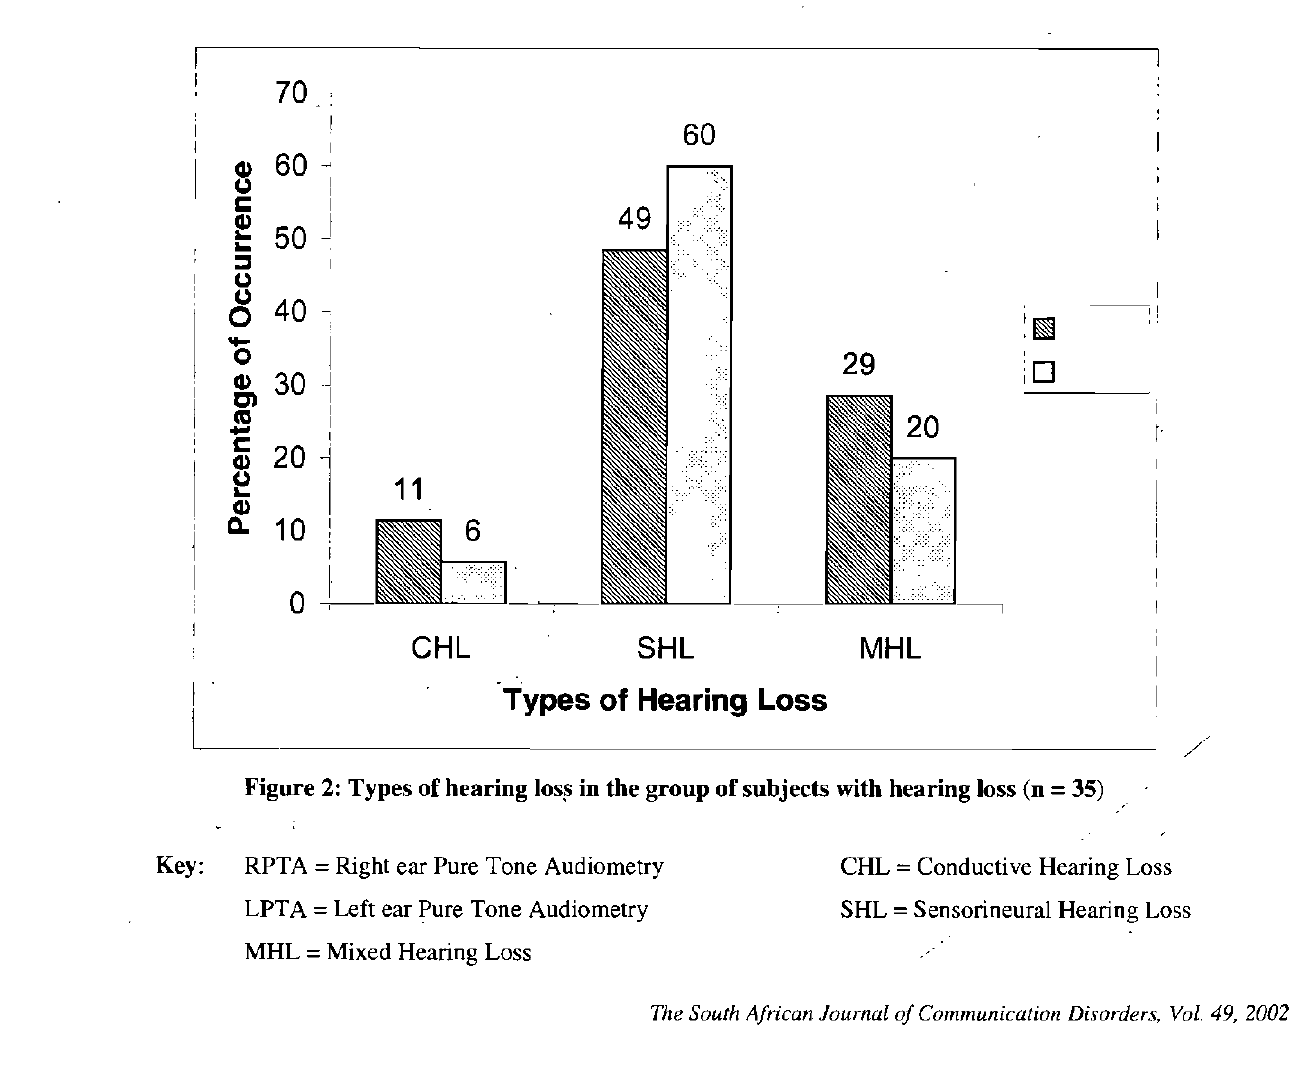
Figure 2: Types of hearing loss in the group of subjects with hearing loss (n = 35) Key: RPTA = Right ear Pure Tone Audiometry LPTA = Left ear Pure Tone Audiometry MHL = Mixed Hearing